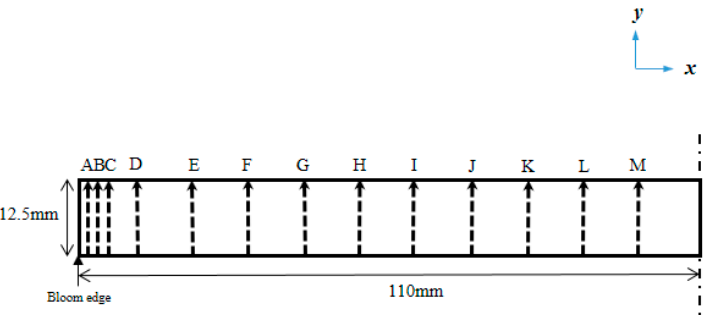
Figure 3. Schematic of measurement location of etched surface height at each position in inner or outer curve side for velocity magnitude calculation. (The bloom edge is corresponding to that in Figure 2. The distance to the bloom edge at A–M positions are 1, 3, 5, 10, 20, 30, 40, 50, 60, 70, 80, 90 and 100 mm, respectively. From down to up, the measuring length is 12.5 mm at each position where 50,001 measurement points are contained).